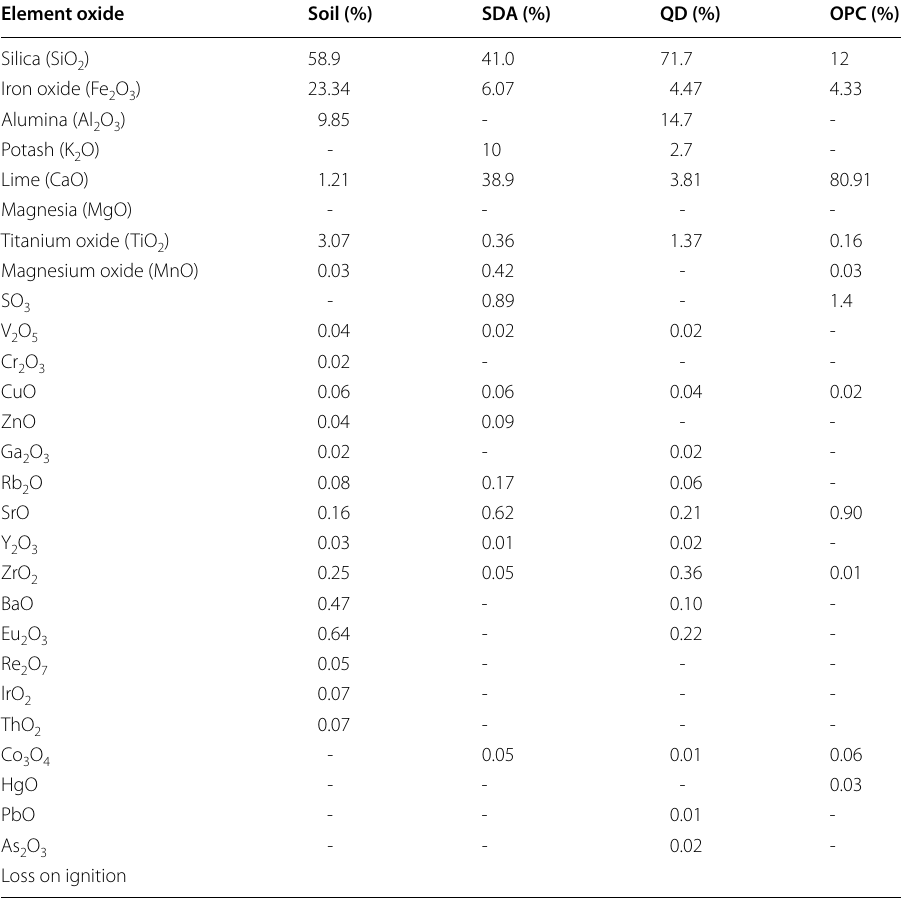
Table 2 Chemical analysis of expansive soil, SDA, QD and OPC